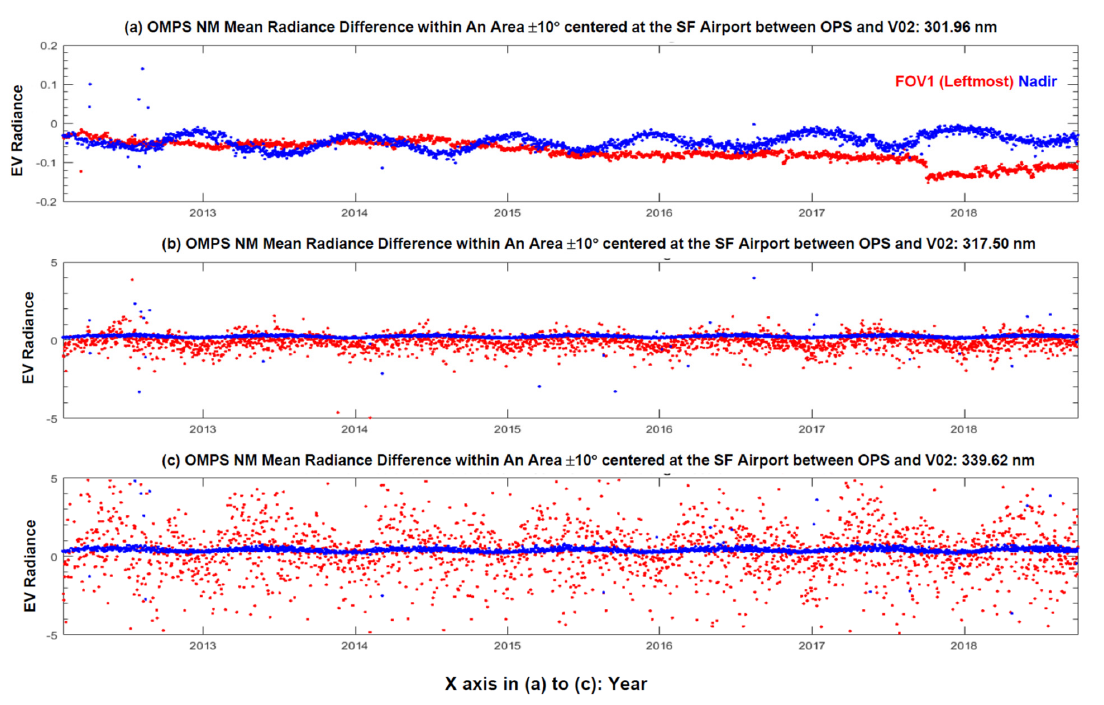
Figure 12. Time series of long–term SNPP OMPS NM averaged radiance differences at three wave- lengths (301.96 nm, 317.497 nm, and 339.622 nm) over the small box (10° × 10°) along the San Fran- cisco International airport among the three data sets; ( a ) 301.96 nm, ( b ) 317.497 nm, ( c ) 339.622 nm.